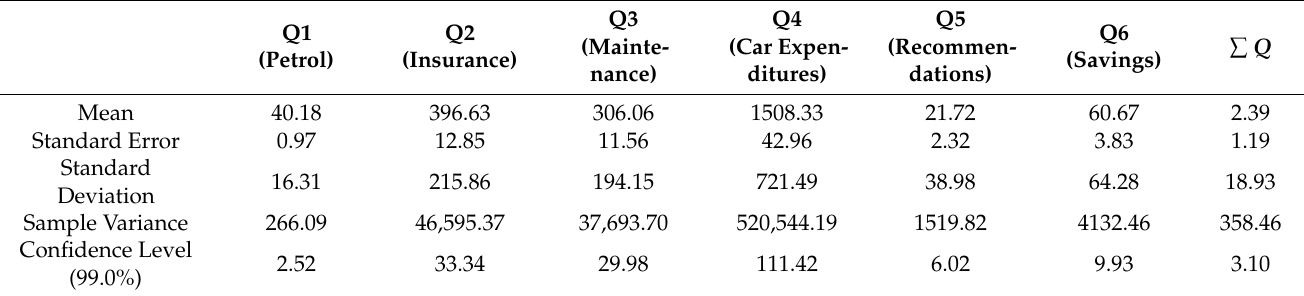
Table 7. Non-connected car statistical data (Section 2 of the questionnaire).